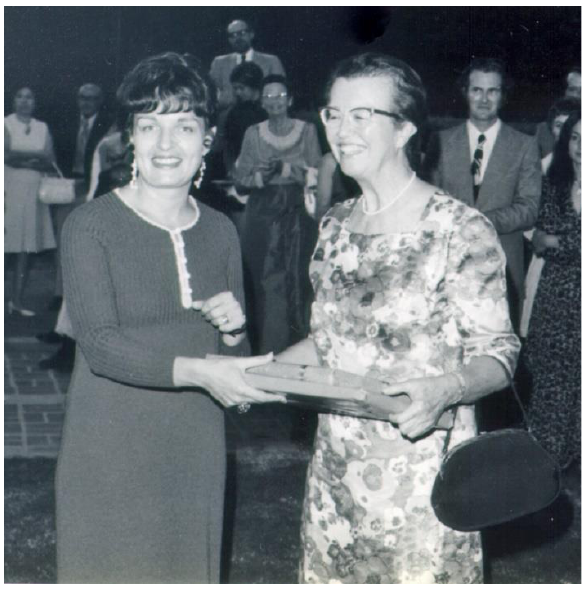
Figure 1 Gloria Werner (left) with Louise Darling (right),